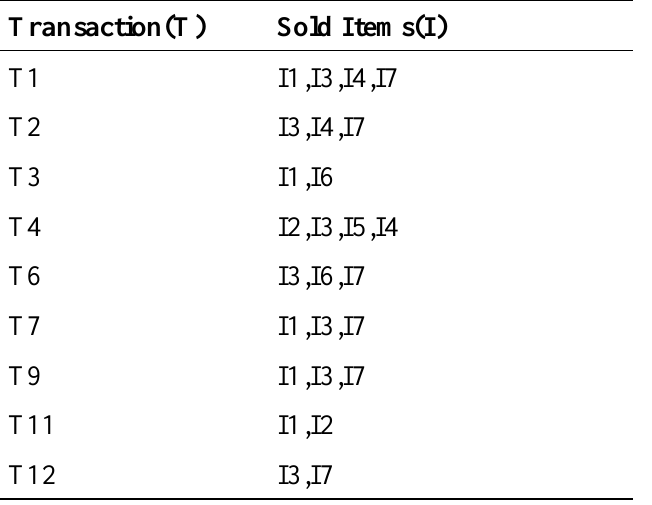
Table 2. Table of Transactions After Deleting Some Useless Taransaction